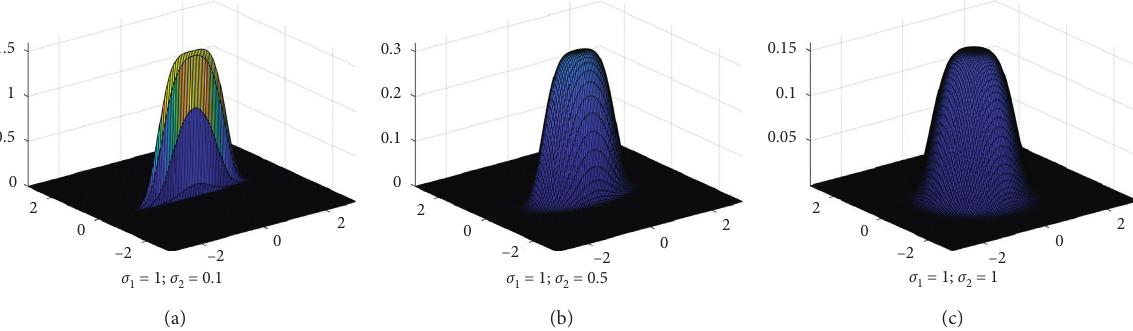
Figure 6: Three-dimensional images of Gaussian kernels with different σ